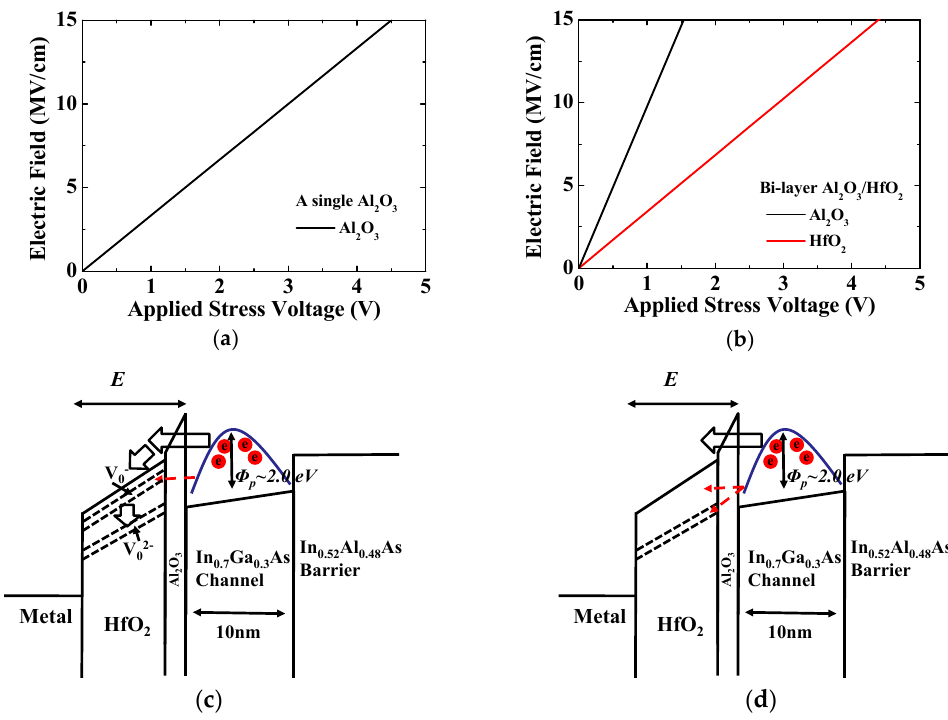
Figure 1. Distribution of each electrical field across ( a ) single-layer Al 2 O 3 and ( b ) bi-layer Al 2 O 3 / HfO 2 on the applied stress voltage. Schematics of energy band diagram of ( c ) single-layer Al 2 O 3 and ( d ) bi-layer Al 2 O 3 / HfO 2 under positive bias temperature (PBT) stress conditions.